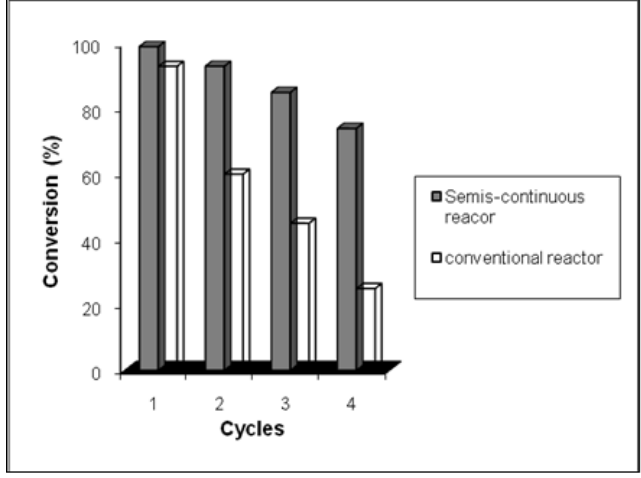
Figure 5. Catalytic activity of the esterification of stearic acid with ethanol, in four consecutive experiments in the conventional and semi-continuous